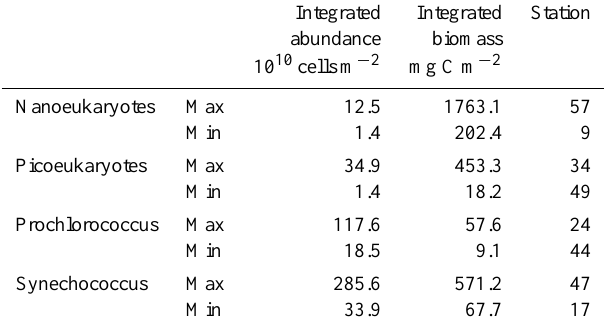
Integrated Integrated